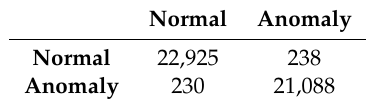
Table 37. Confusion matrix for Bagging Reptree.